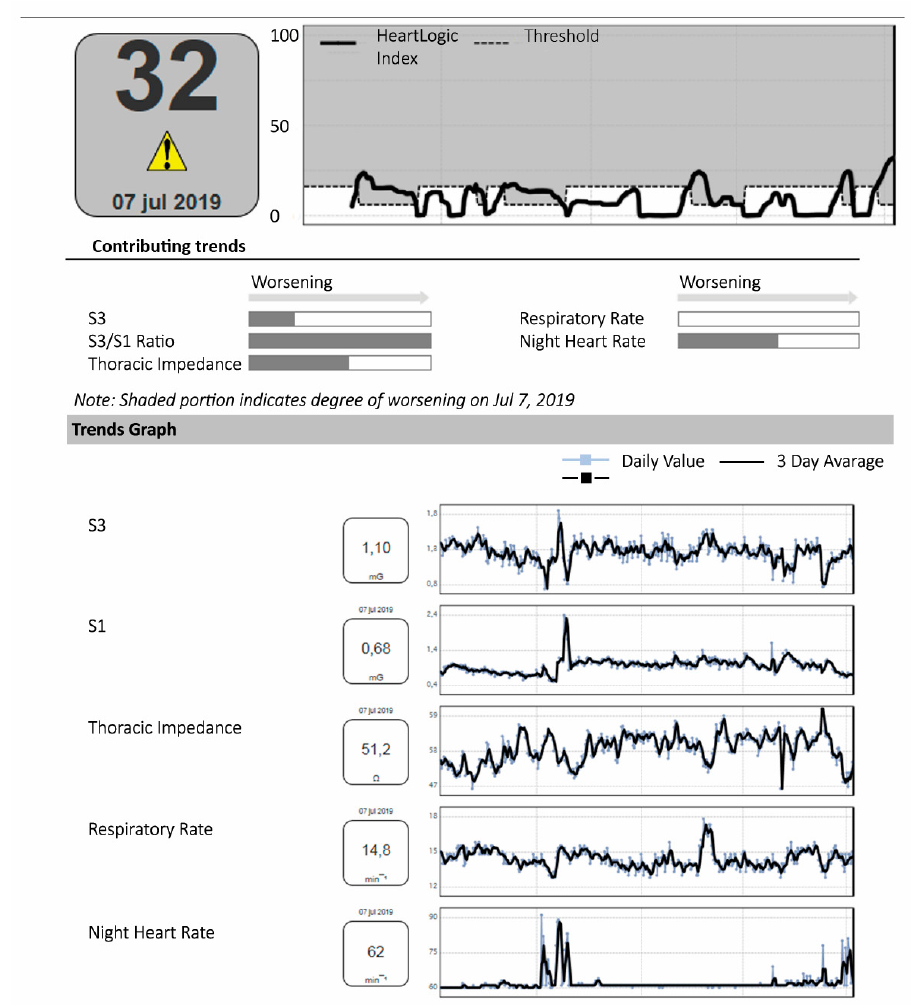
Figure 2. An example of a HeartLogic TM report. The report states the cumulative HeartLogic TM index (top left corner) and provides additional information on the data collected by the individual sensors (contributing trends and trend graph). S1, 1st heart sound; S3, 3rd heart sound.